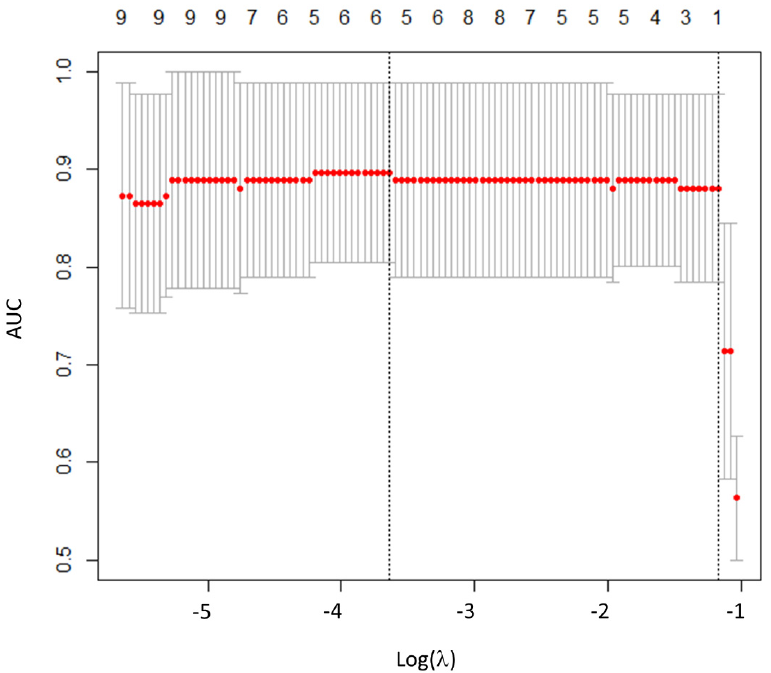
Figure 2. Radiomics features selection using least absolute shrinkage and selection operator